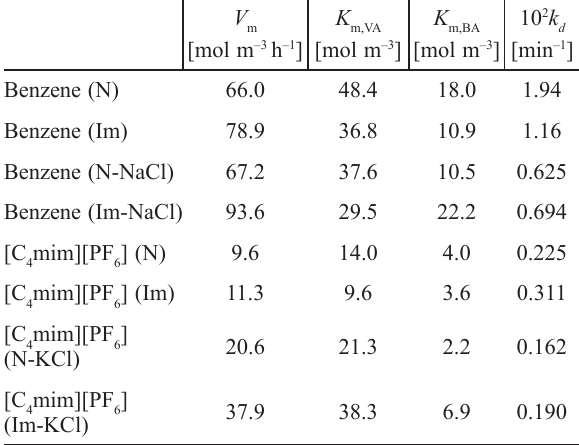
Table 2 – Kinetic parameters for enzymatic transesterifica- tion and deactivation constant of lipase at 60 °C